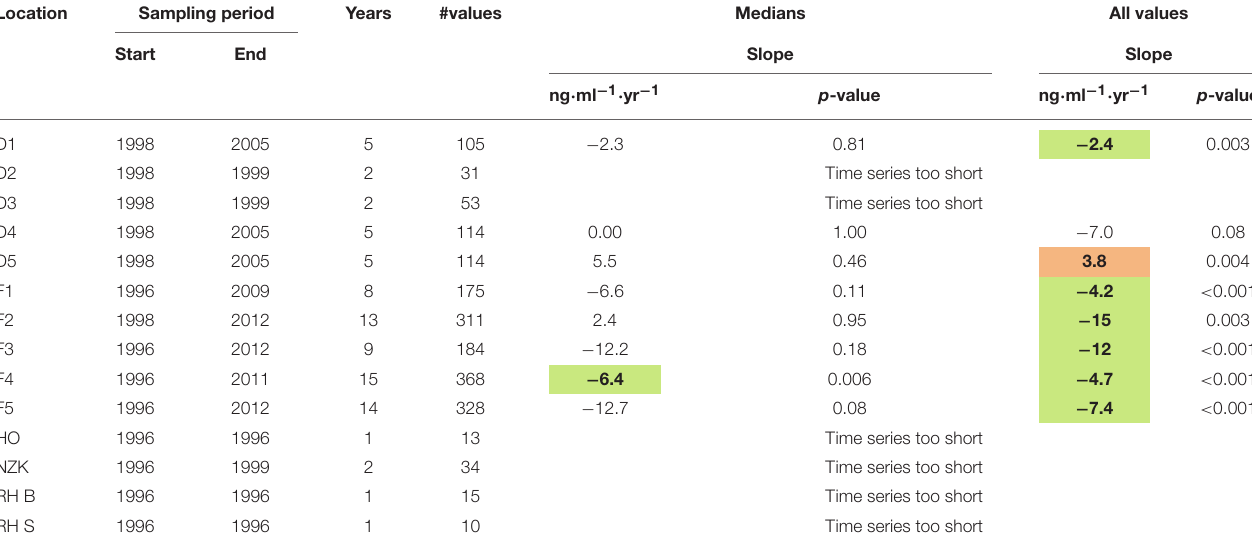
TABLE 1 | Estimated trend slopes of 1-OH-pyrene in fish bile (ng · ml − 1 · yr − 1 ) and corresponding p -values. Location